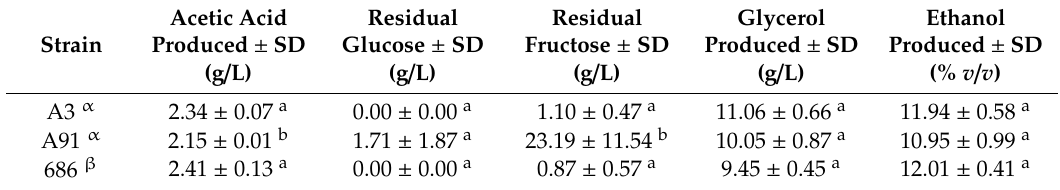
Table 4. Oenological parameters improved strain “686” and their F 1 parental strains. Ethanol Glycerol Residual Residual Acetic Acid Produced ± SD Produced ± SD Fructose ± SD Glucose ± SD Strain Produced ± SD (% v / v ) (g / L) (g / L) (g / L) (g / L) A3 α 2.34 ± 0.07 a 0.00 ± 0.00 a 1.10 ± 0.47 a 11.06 ± 0.66 a 11.94 ± 0.58 a A91 α 2.15 ± 0.01 b 1.71 ± 1.87 a 23.19 ± 11.54 b 0.00 ± 0.00 a 0.87 ± 0.57